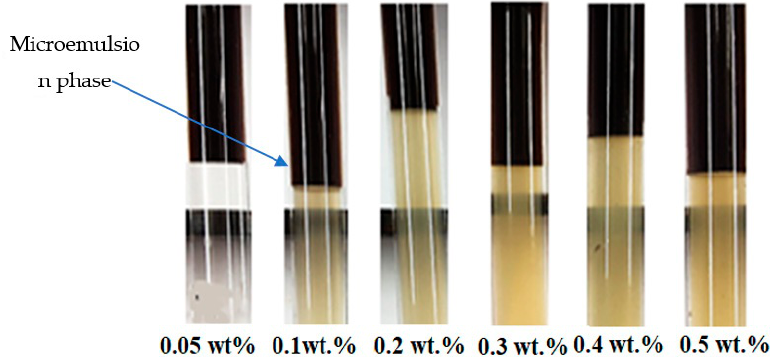
Figure 8. Phase behavior of as-synthesized surfactant with 35 wt.% co-solvent mixture at different concentrations in ratio B (3:1). concentrations in ratio B (3:1).